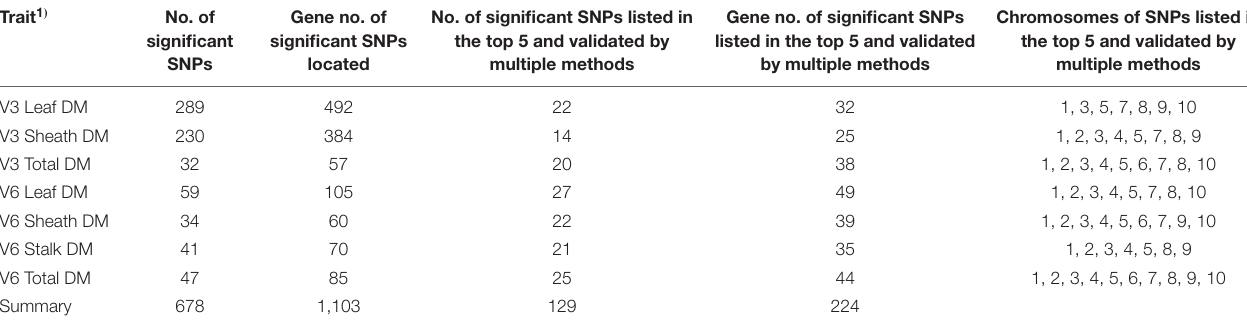
FIGURE 5 | The broad-sense heritability ( H 2 ) of dry matter related traits at the V6 stage. TABLE 2 | Statistics and summary of significant loci obtained by GWAS for each